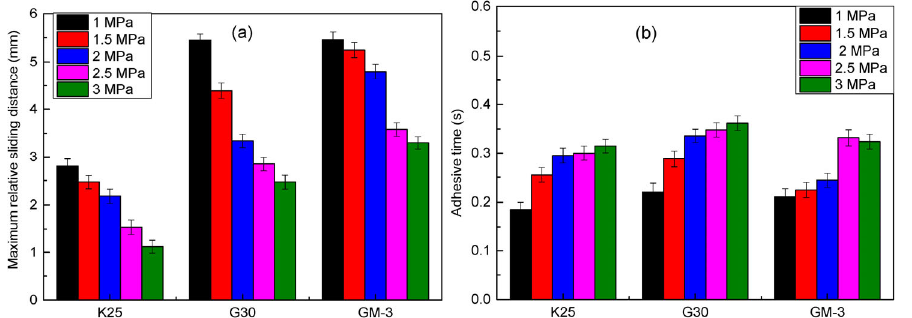
Fig. 9 Maximum relative sliding distance and adhesive time of the friction lining under different pressures: (a) Maximum relative sliding distance and (b) adhesive time.